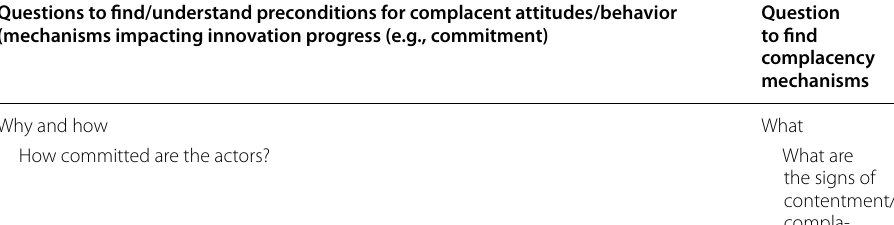
Table 3 Questions inspired by Kotter (2008) signs of complacency used for data